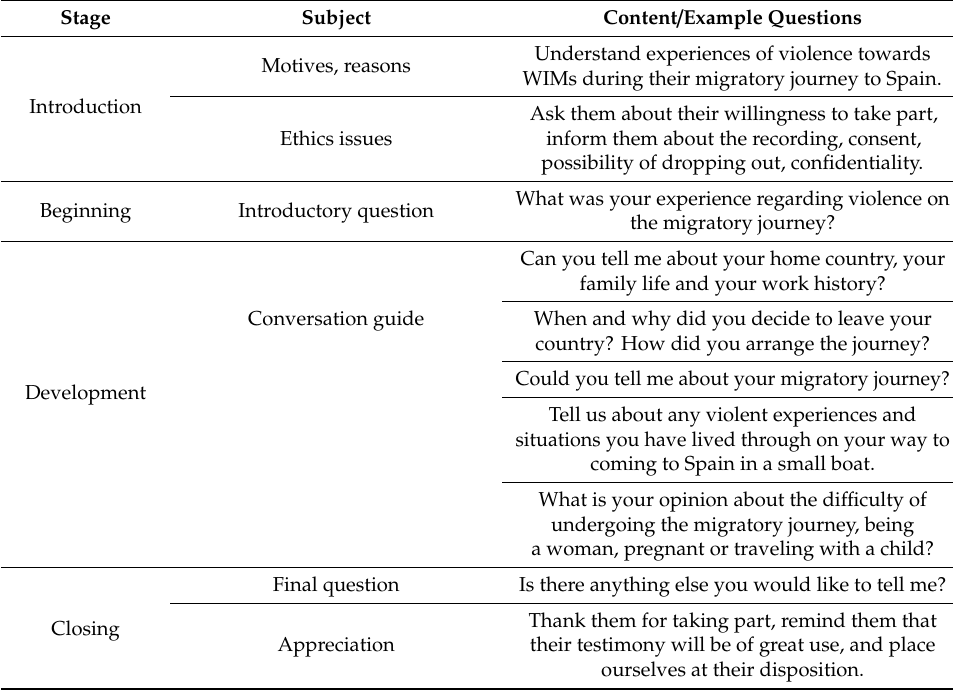
Table 2. Interview